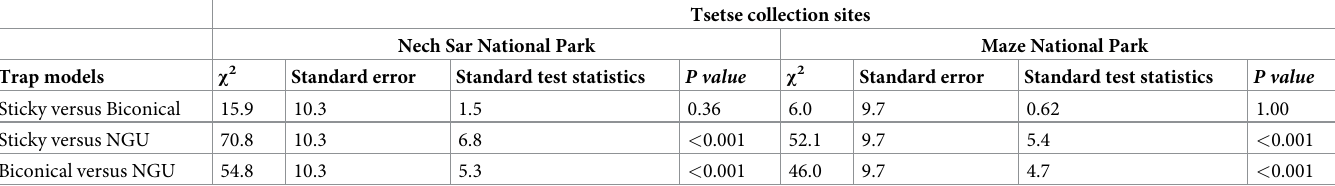
Table 2. Efficacy of traps in in catching G . pallidipes in Nech Sar and Maze National Parks, Southwest Ethiopia.